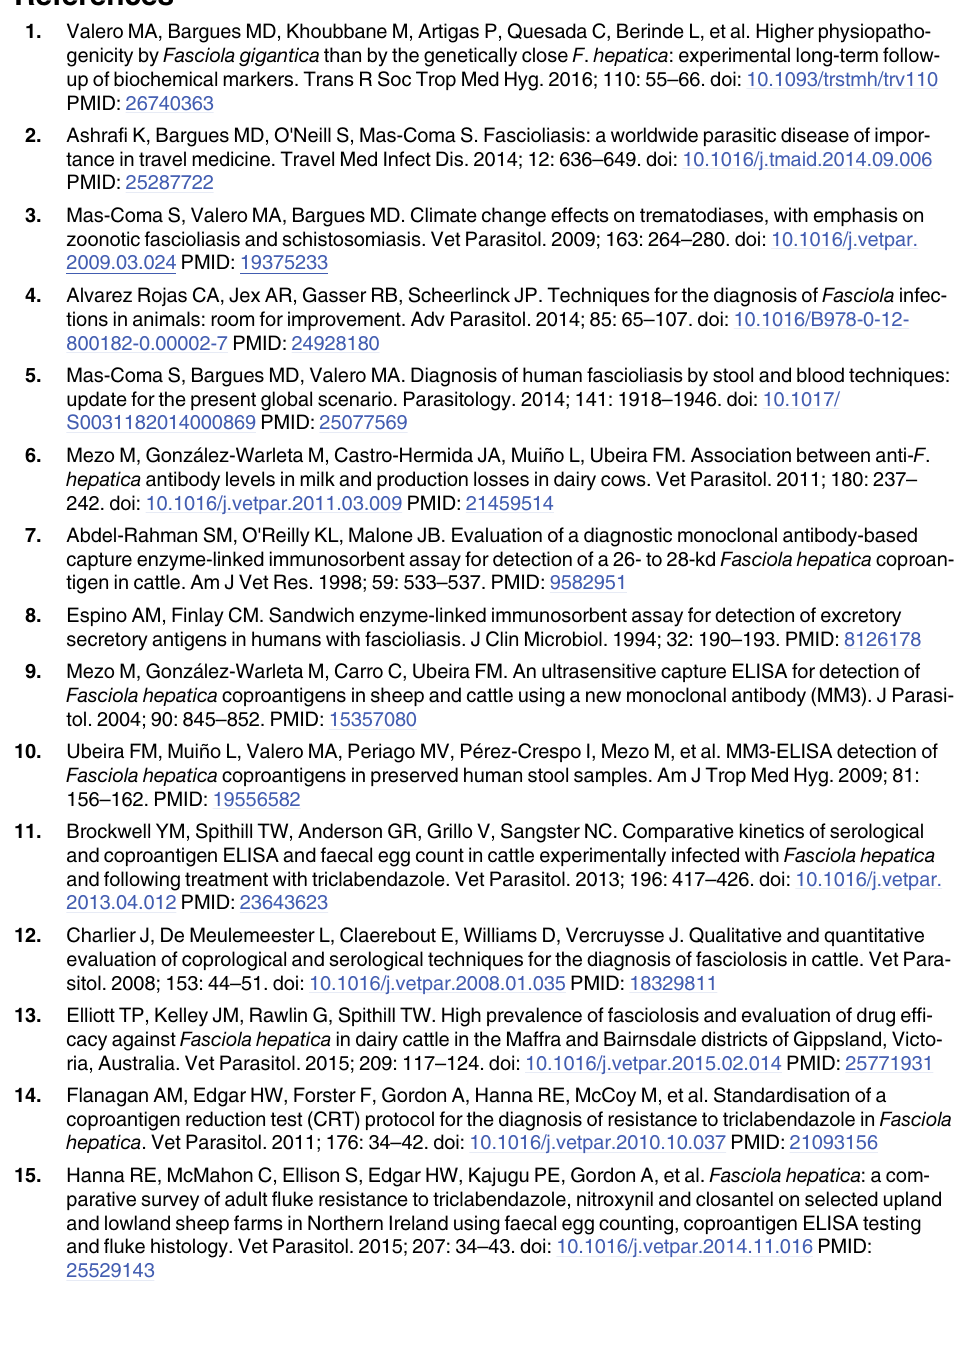
S1 Table. STARD checklist of the